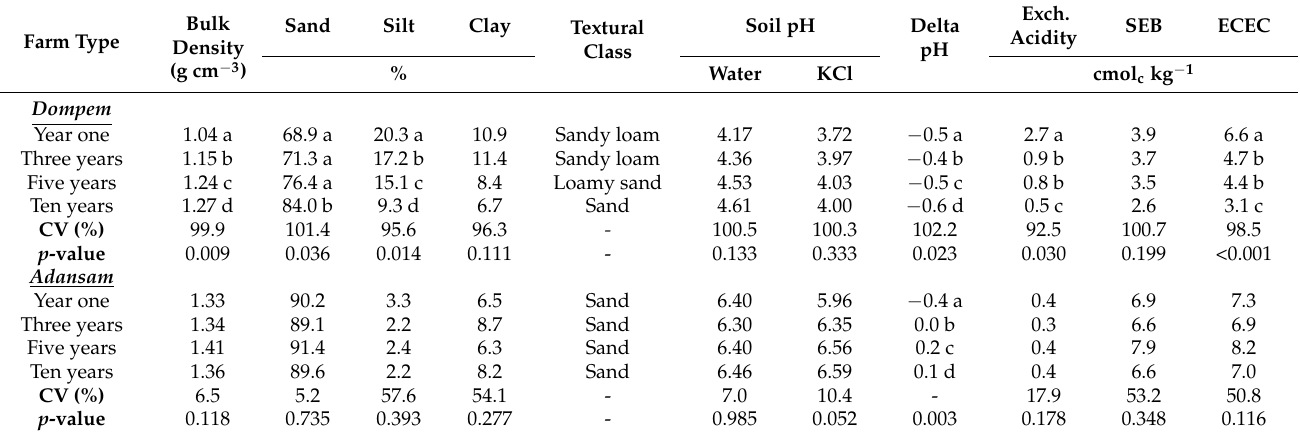
Table 2. Soil bulk density, particle size distribution, soil pH (water and KCl), delta pH, exchangeable acidity, sum of exchangeable bases and the effective cation exchange capacity (ECEC) of soils from different farm types in Dompem ( n = 9) and Adansam ( n = 11) with coefficients of variation and p -values.